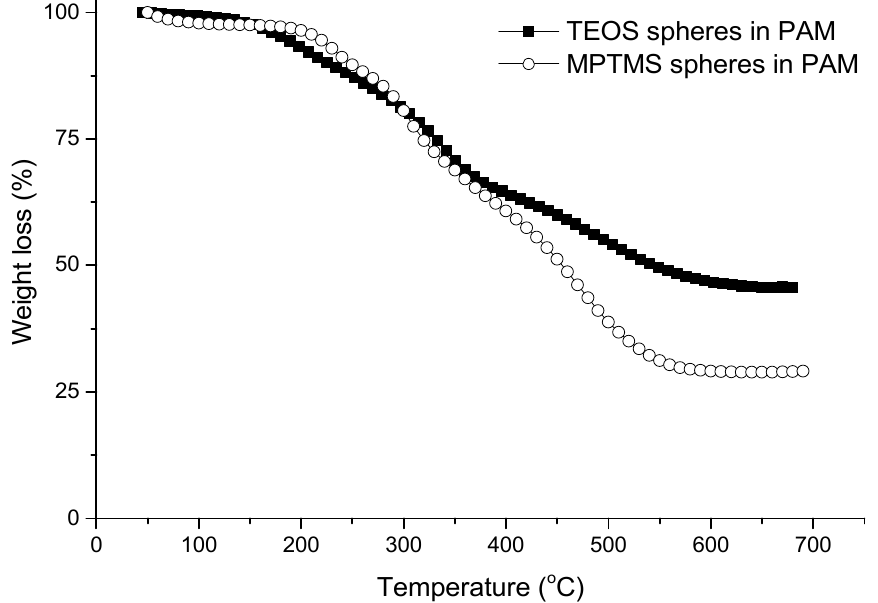
Figure 2. TGA profiles of silica microspheres–PAM composite beads synthesised using TEOS and MPTMS as the silica precursors, respectively.